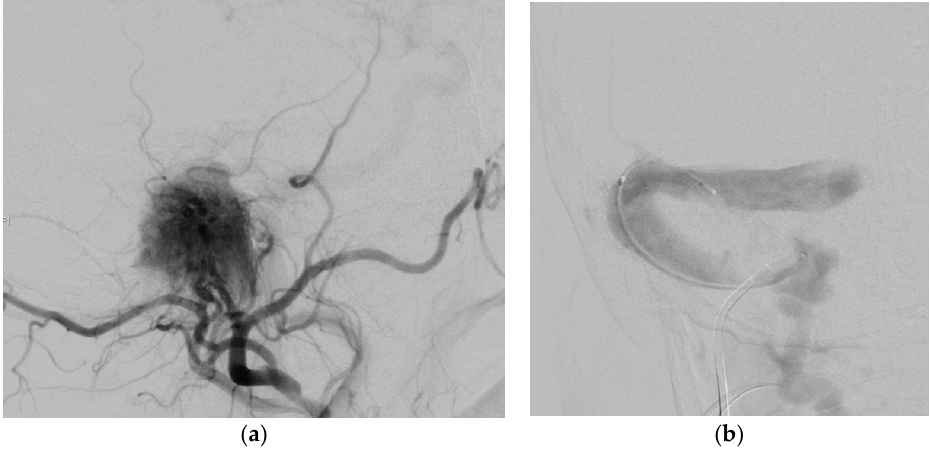
Figure 5. ( a ) DSA demonstrate feeding vessels from the external carotid artery; ( b ) DSA reveal reduced flow through both transverse and sigmoid sinus into the internal jugular vein.